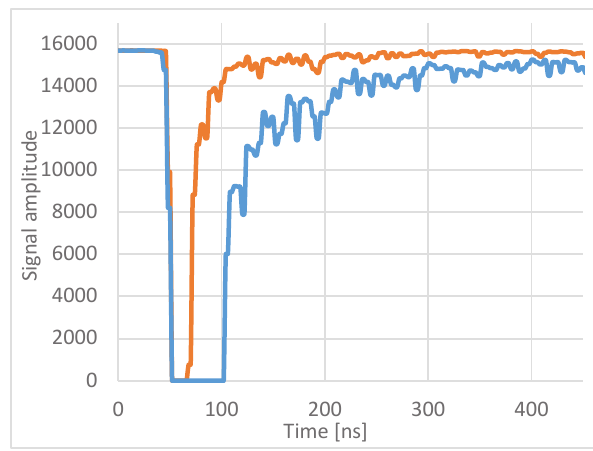
Figure 7 Stilbene data from the DAQ for 230 keV neutrons In Figure 7 (c), the total pulse height spectra (in blue) is plotted, as well as the derived neutron PHS after selecting the neutron contributions in the time interval 390 < Δt < 425 ns. neutron fields from Table 1. The monoenergetic peak is clearly visible even at 84 keV, the lowest energy. The corresponding recoil proton energy distributions were obtained by selecting only the events corresponding to the monoenergetic neutrons in the time interval, as shown in Figure 9 . These distributions will be used to validate upcoming calculated responses of the stilbene scintillator.